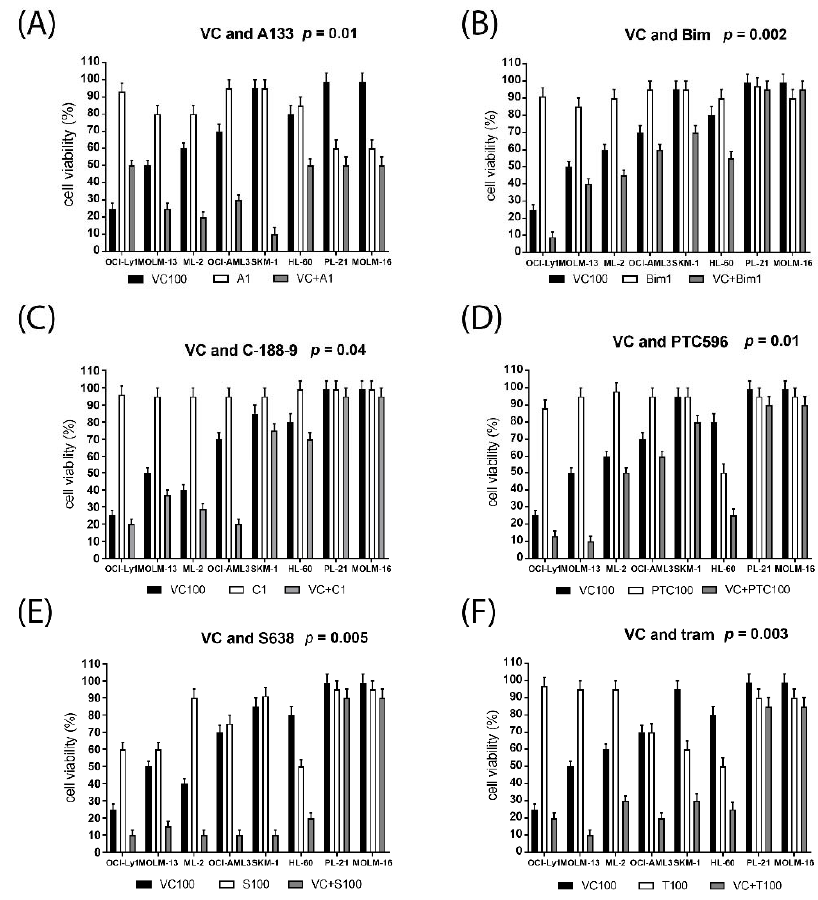
Figure 2. Susceptibility of leukemic cells to venetoclax combination treatment. Cell viability was determined in one lymphoma and seven AML cell lines treated for 20 h with single compounds and in combination with 100 nM venetoclax (VC) and 1 µ M A1331825 ( A ), 1 µ M bimiralisib ( B ), 1 µ M C188-9 ( C ), 200 nM PTC596 ( D ), 100 nM S63845 ( E ), or 100 nM trametinib ( F ). Significance was calculated in a graph pad prism using grouped analysis with paired t -test comparing cell viabilities of VC treated and combination treated cells. A significance level of 0.05 indicates a 5% risk of concluding that a difference exists when there is no actual difference. Table 3. Combination index values of AML cell lines.